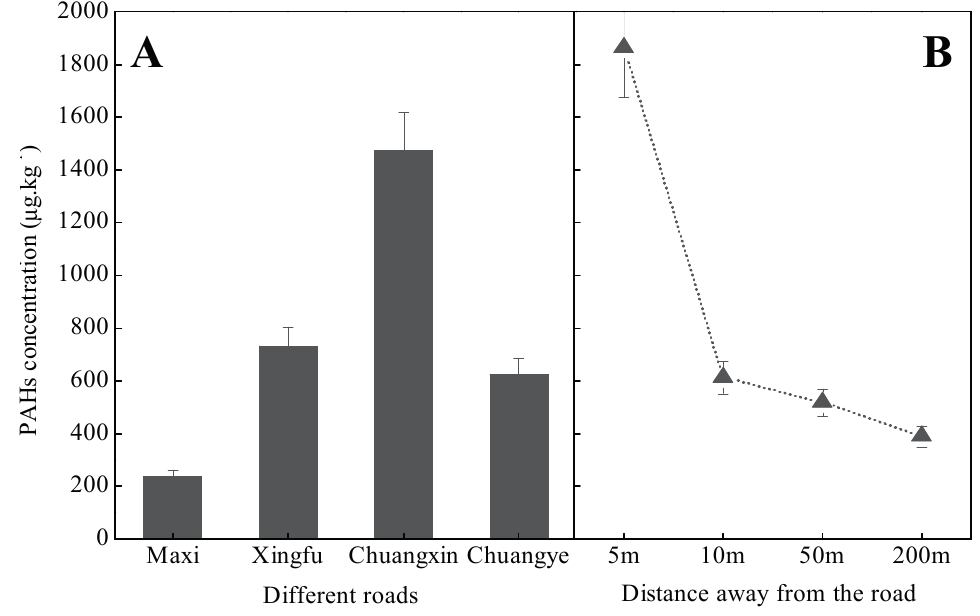
Figure 5. Changes of the means concentrations (µg·kg − 1 ) of ∑ PAH in the site soils along the different roads. Notes: ( A ): shows the means concentrations of ∑ PAH for different sites along the different road; ( B ): shows the change of the mean concentrations of ∑ PAH along a gradient with distance (D) from a road at D < 5m, 5m < D < 10m, 10m < D < 50m, and 50m < D < 200m,